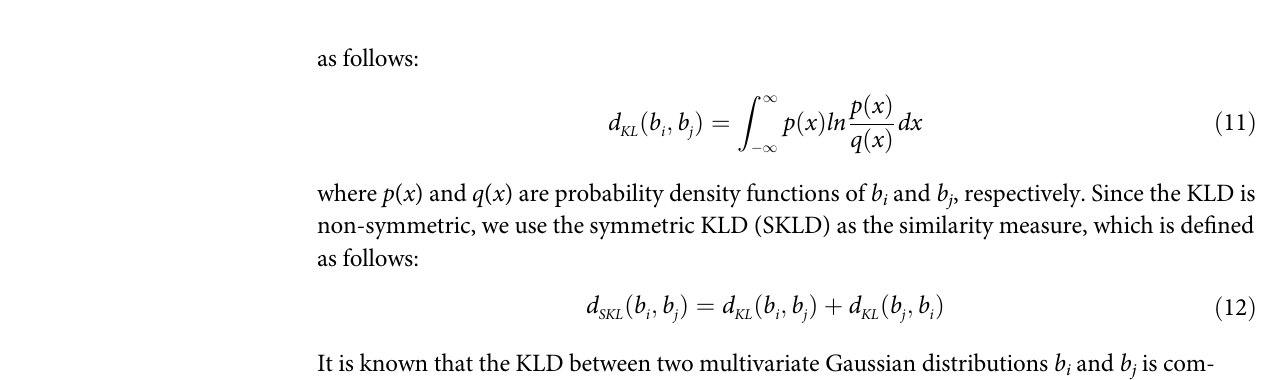
Fig 3. Seven anatomic bundles of twelve example subjects. Seven anatomic bundles which were obtained through manual labeling for left hemispheres of twelve example subjects.